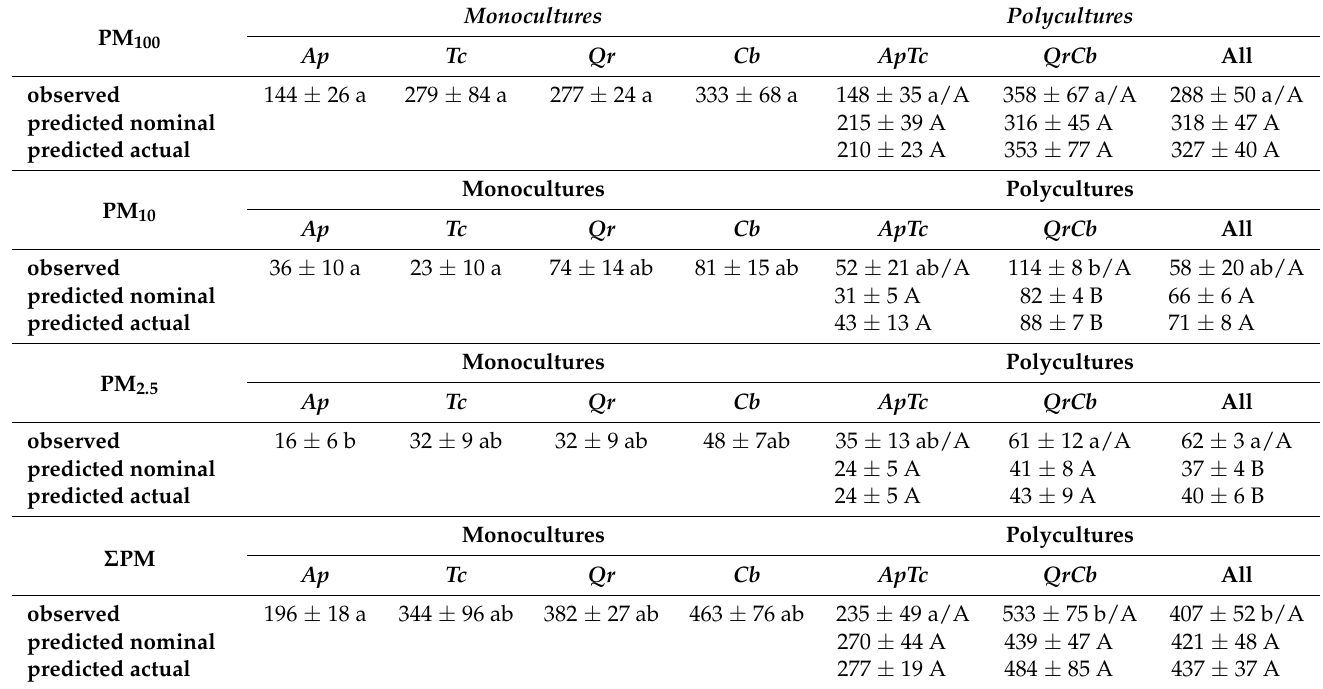
Table 3. Mean PM 100 , PM 10 , PM 2.5 and Σ PM removed from leaves per square meter stand area (mg · m − 2 ) and standard error (SE) of the monocultures and polycultures. The row observed shows measured values of PM removed from leaves of the monocultures and an approximately 50:50 leaf area mixture of the two species in two species polyculture or 25:25:25:25 in 4 species polyculture (All). Predicted nominal shows values of PM binding calculated for the polycultures from PM binding of the monocultures Ap , Tc , Qr and Cb and using the same leaf areas as in observed. Predicted actual shows values of PM binding calculated for the polycultures from PM binding of monospecific plots and the measured LAI values in the polyculture plots. Within a PM class, in rows, different lower-case letters indicate significant differences between monocultures and polycultures. In columns, different capital letters indicate significant differences between the observed and predicted values. (one-way ANOVA, p < 0.05). A. platanoides ( Ap ), T. cordata ( Tc ), Q. robur ( Qr ), C. betulus ( Cb